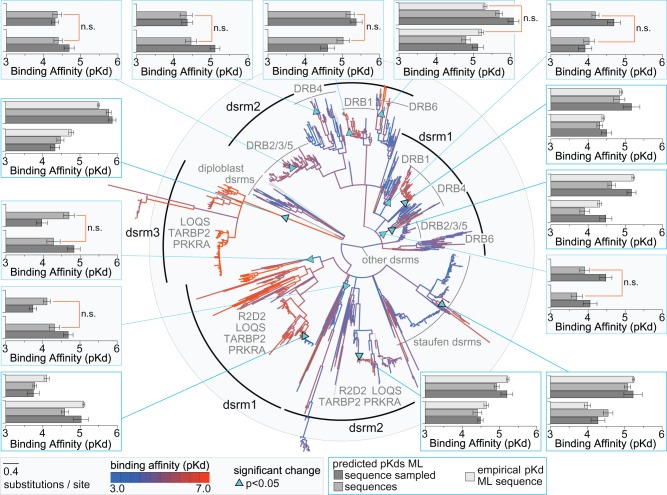
Dsrm–RNA affinities changed often across animal and plant lineages. We inferred the maximum-likelihood phylogeny of dsrm protein sequences using a structure-based alignment (see Materials and Methods). Branch lengths are scaled to substitutions/site, and clades with <0.8 SH-like aLRT are collapsed. Ancestral dsrm sequences were reconstructed at each node on the tree, and dsrm–RNA structural complexes were inferred by homology modeling and molecular dynamics (see Materials and Methods). Dsrm–RNA affinities were predicted by statistical machine learning (see Materials and Methods). We color branches by the average dsrm–RNA binding affinity (pKd) across multiple replicate models of each ancestral and extant sequence on the phylogeny, with red indicating high-affinity and blue indicating low-affinity. Triangles indicate branches on which there was a significant change in predicted pKd, as indicated by FDR-corrected independent t test. Boxes plot the predicted affinity of the maximum-likelihood ancestral sequence (dark gray), random samples drawn from the ancestral state probability distribution (medium gray) and the experimentally determined affinity (light gray) before (bottom) and after (top) the observed shift. Bars indicate standard errors, and results that were not significant (n.s.) using either sampled sequences or empirical affinity measurements are indicated.